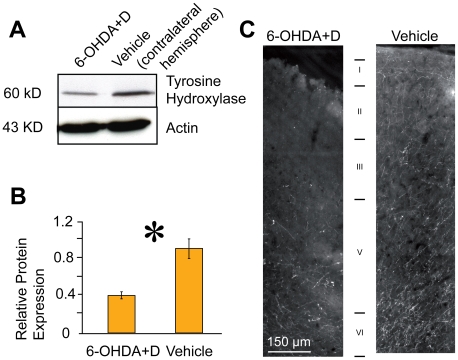
Identification of dopaminergic terminals in M1.(a) Western blot analysis of M1 cortical tissue injected with vehicle (sham-lesioned) and 6-OHDA in conjunction with desipramine (i.p.) using tyroxine hydroxylase (TH) reactivity indicated reduced TH expression after elimination of dopaminergic terminals. (b) Quantification of protein expression in DA-lesioned (6-OHDA+D) and sham-lesioned hemispheres reveals reduced protein expression after elimination of dopaminergic terminals. (c) Immunofluorescence staining of cortical dopaminergic terminals (TH immunoreactivity) in an exemplary vehicle and DA-lesioned hemisphere (6-OHDA injections into M1) indicated almost no staining in layer I and II/III and reduced staining in deeper layers in the lesioned M1. Similar findings were obtained in the other two animals treated analogously.